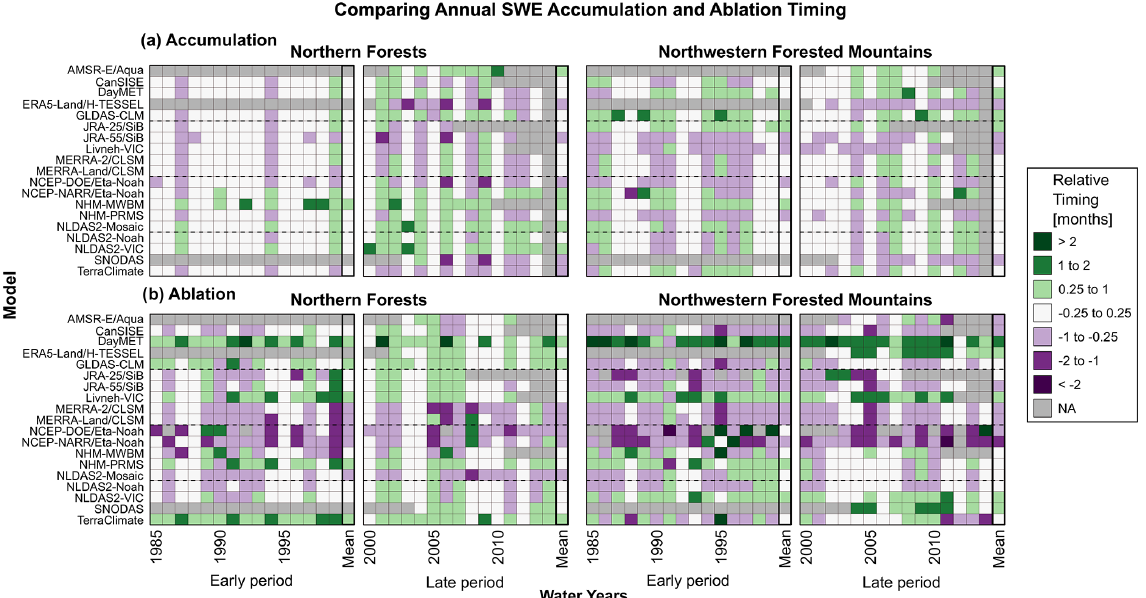
Figure B3. Heat maps showing the relative timing of the beginning of snow water equivalent (SWE) accumulation (a) and ablation (b) periods for two ecoregions from 1985 to 2014. Relative timing is the difference between the month of the beginning of a model’s accumulation or ablation period and the mean of all other model’s timing. The beginning of accumulation and ablation is defined as when the rate of change of SWE between months is greater than 1mm per month or less than − 1mm per month, respectively.